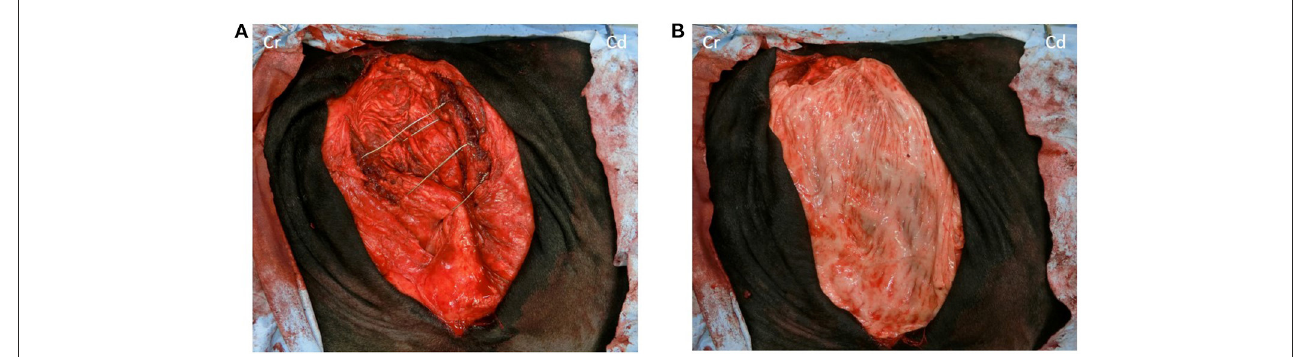
FIGURE3 (A) No musculature is observed under the skin of the hernia foramen, only white peritoneum; ventral two-thirds of the last rib and between the seventh and eighth ribs and ventral one-sixth of the last rib and the ventral end of the last rib is wired to the eighth and ninth rib to reduce the intercostal space as much as possible. (B) The hernia rings are covered with a large autogenous-free graft. Cr, Cranial; Cd, Caudal.